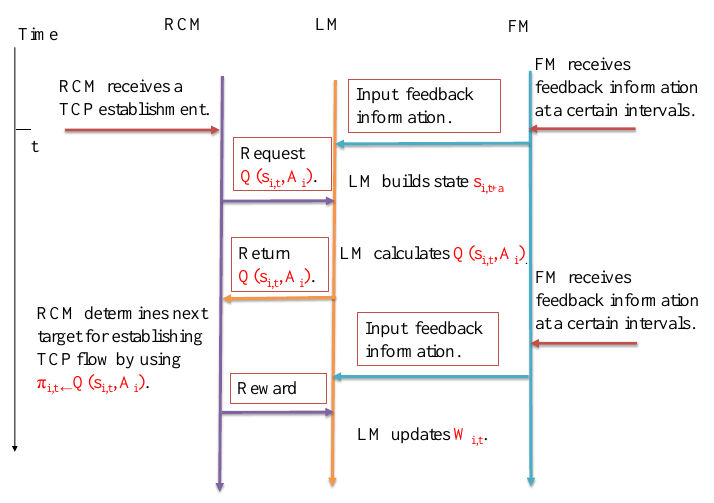
Figure 5. An sequence diagram of the proposed scheme’s